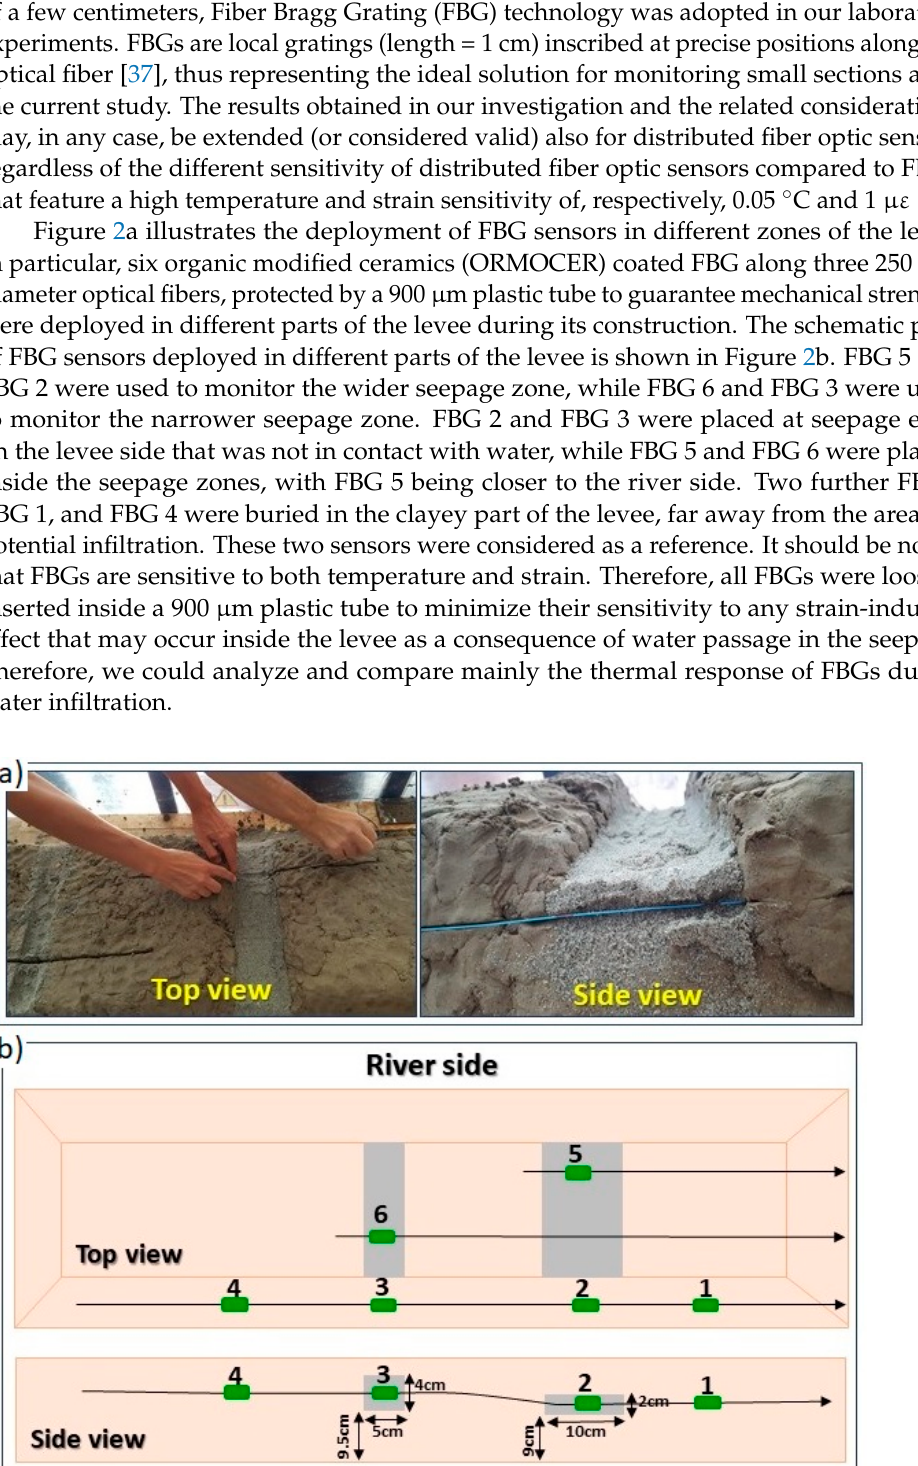
3. Data Processing and Results Before inverting ERT datasets, they were cleaned for negative resistance values and extremely low injected currents. We usually remove bad quality data that have standard deviations larger than 2%, but since high-speed measurements did not provide the quality factor, this criterion could not be considered in this study. However, we performed some check measurements at random times using the stacking options to validate the high- speed measurements. A further and important consideration before inverting the ERT datasets was to cor- rect them for 3D effects. It is known that the 3D geometry can significantly disturb 2D ERT data measured along embankment structures like dams and river levees [38–40]. Since the level of water in the river side is an important parameter that can significantly change 3D effects [40], water level in the river side was continuously measured in our experiments. Moreover, the level of water on the other side of the levee was also measured continuously during the period when water was exiting from seepage zones. Apparent resistivity pseu- dosections measured at each time were then corrected for 3D effects using the approach discussed by Hojat et al. (2020) [36]. To do this, the 3D levee and its boundary conditions at different times were reconstructed in RES3DMODx64 (www.geotomosoft.com). It